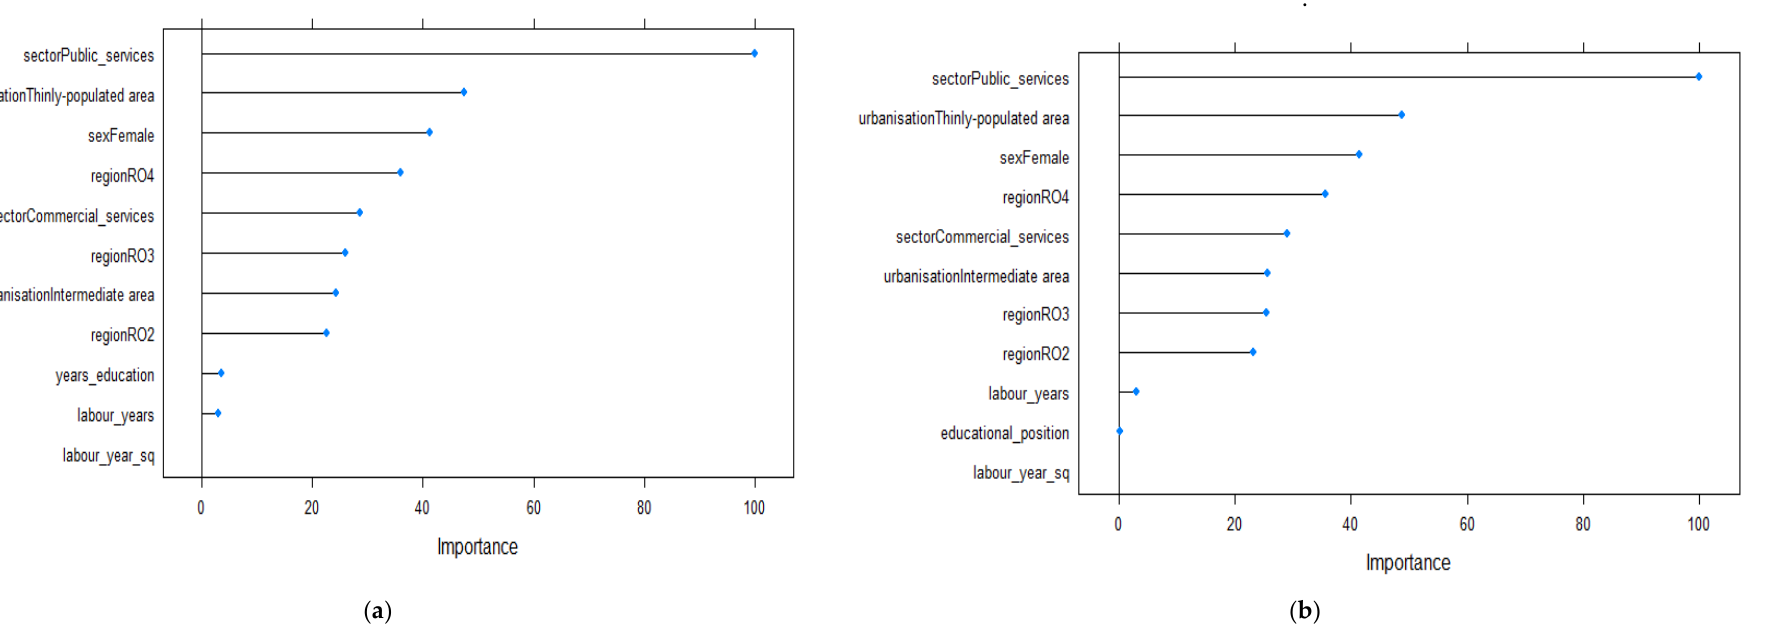
Figure 2. Relevant variables in explaining the variations in wages based on the Enet method for the 24 years old and younger age group ( n = 155): ( a ) model 1 using the absolute measure of education; ( b ) model 2 using the relative measure of education.